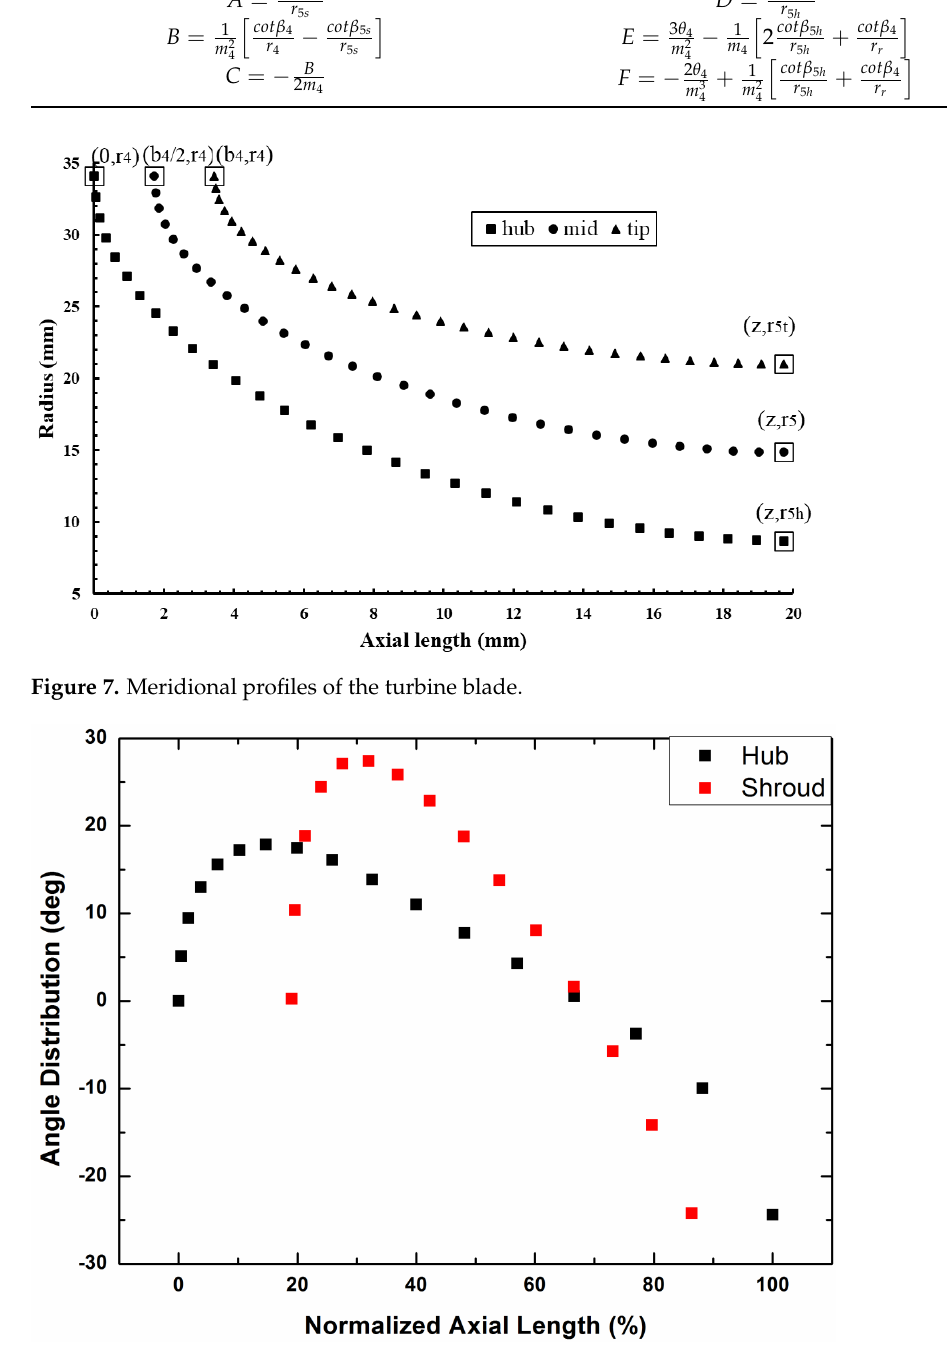
Figure 8. Distribution of rotor blade angles.